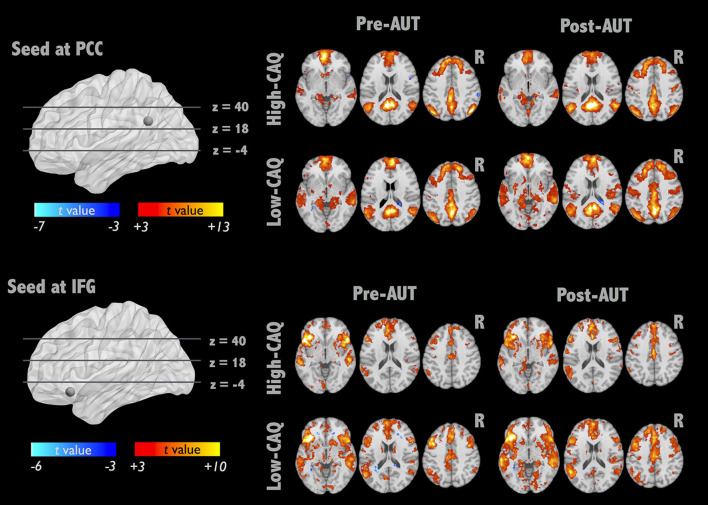
IFGN and DMN RSFC patterns before and after AUT. For each network, the top panel displays the one-sample RSFC map of Pre-AUT and Post-AUT for the high-creative group, and the lower panel refers to the low-creative group.